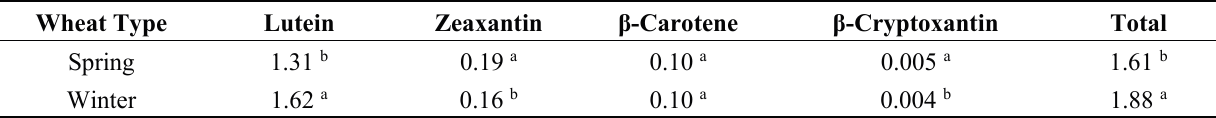
Table 3. Difference between spring and winter for different carotenoids content (mg/kg) in organically produced wheat